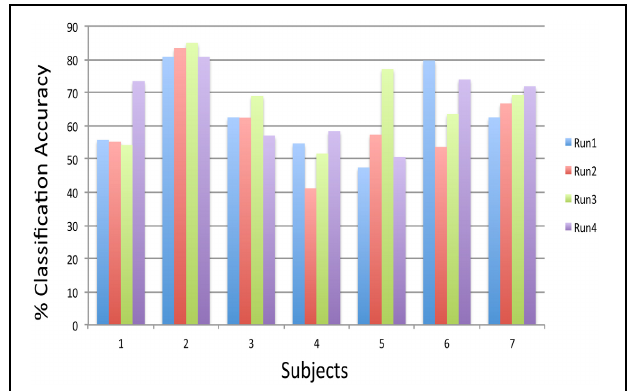
FIGURE 12 | Subject-independent Classifier (SIC): classification accuracies of subjects performing happy and disgust imagery guided by the feedback calculated from a model, which was built on 12 subjects data, across four feedback runs. The chance level is 50% (Rana et al.,